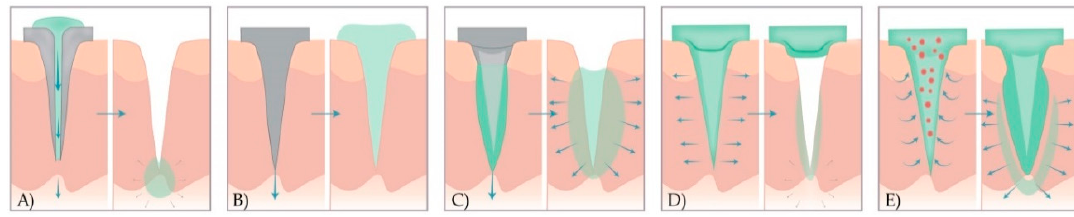
Figure 2. A schematic representation of drug release methods with five different types of MNs. ( A ) Hollow MNs pierce the skin (left) and provide the release of liquid drug formulation through the needle lumen (right). ( B ) Solid MNs pretreat the skin to create transient microchannels skin (left) and increase the permeability of the drug that is then, applied in the form of a transdermal patch, solution, cream, or gel (right). ( C ) Coated MNs with drug formulation (left) enable the fast dissolution of the coated drug in the skin (right). ( D ) Dissolving MNs are prepared from polymer and embedded drug in the MN matrix (left) to provide the bolus or controlled delivery of a drug (right). ( E ) Hydrogel MNs poke the skin, uptake interstitial fluids (right), and induce diffusion of the drug from the patch through the swollen MNs (left).